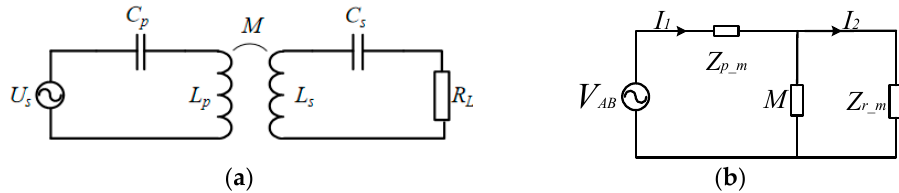
Figure 2. Mutual inductance model: ( a ) S-S compensated wireless power transfer syste, ( b ) impedance model of S-S compensated WPT system.